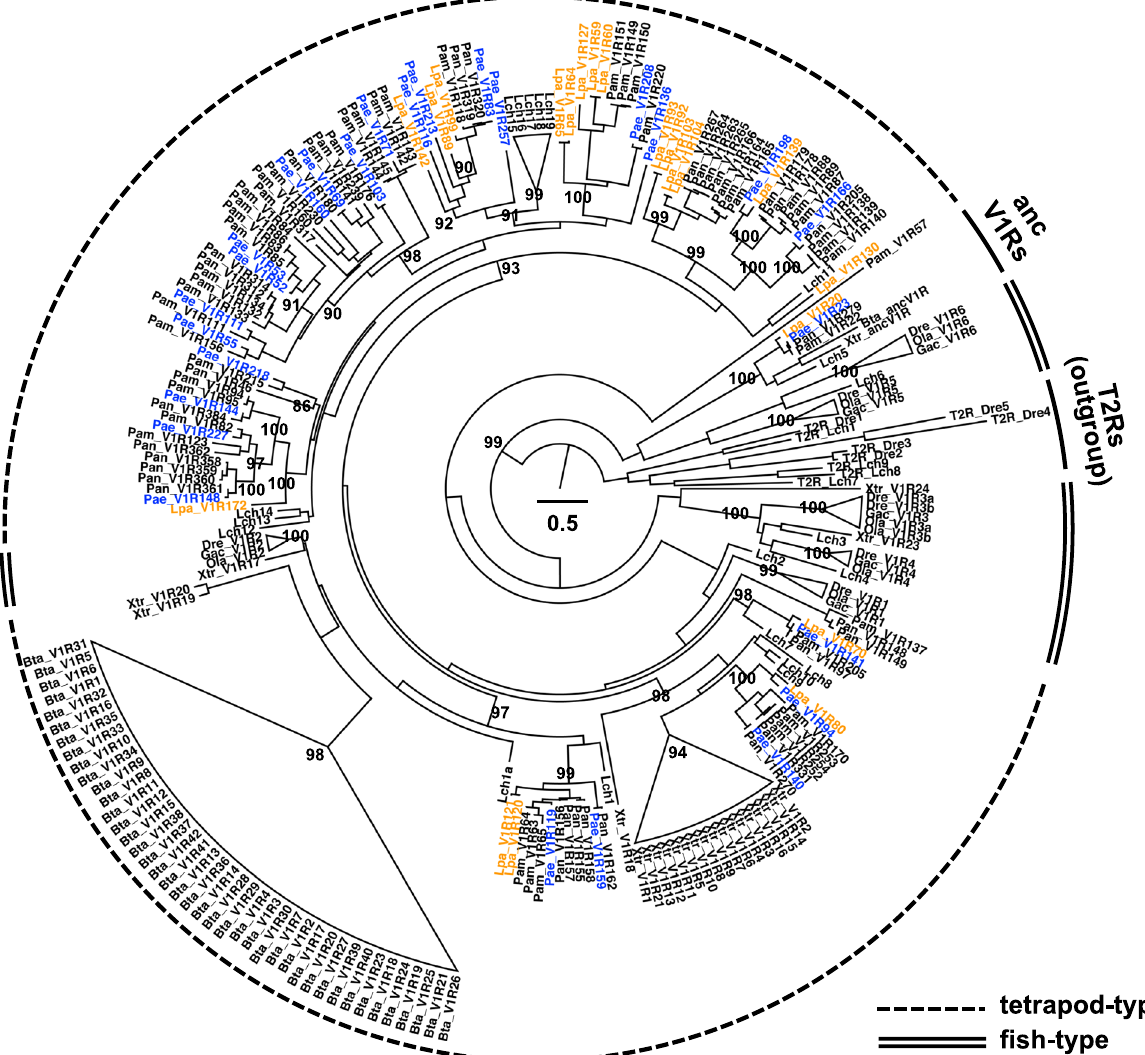
Fig. 4 Phylogenetic tree of V1R genes of four lungfish. The names of the sequences are as follows: Pae, P. aethiopicus ; Lpa, L. paradoxa ; Pan, P. annectens ; Pam, P. amphibius ; Ola, medaka; Gac, stickleback; Dre, zebrafish; Lch, coelacanth; Xtr, tropical clawed frog; and Bta, cow. Newly identified lungfish V1Rs are indicated in blue ( P. aethiopicus ) and orange ( L. paradoxa ). Scale bars indicate the number of amino acid substitutions per site. T2Rs (bitter-taste receptors) were used as the outgroup. Bootstrap values higher than 80 were shown only for major nodes of the phylogenetic tree. Tetrapod-type and fish-type V1Rs are indicated by dotted and double lines,